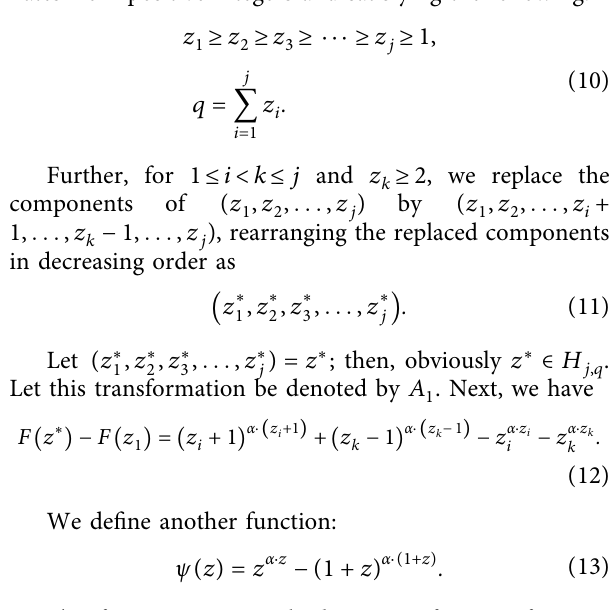
Figure 4: Plot for Y